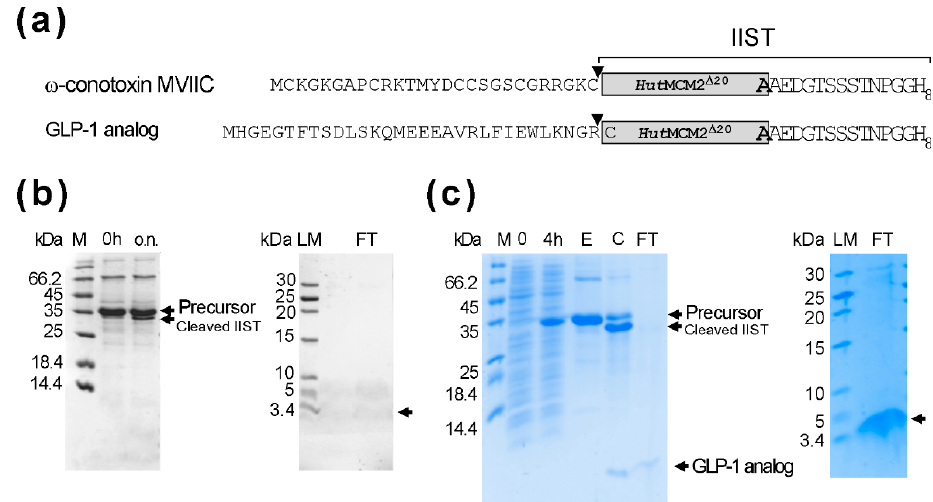
Figure 6. Expression and purification of a GLP-1 analog and ω -conotoxin MVIIC using the smaller IIST ( a ) A schematic drawing of the fusion constructs bearing a GLP-1 analog or ω -conotoxin MVIIC. Inverse triangles indicate the cleavage sites. ( b ) Salt-cleavage of ω -conotoxin MVIIC with the smaller IIST. 0 h and “o.n.” indicate the samples before the salt addition or after 15-h incubation in the salt solution (2 M NaCl, 50 mM DTT, 50 mM Tris-HCl, pH 7). LM and FT indicate low molecular weight markers and the flow-through fraction from the second IMAC, respectively. ( c ) Expression, purification, and cleavage of a GLP-1 analog with IIST. M stands for molecular weight markers. Lanes 0 h, 4 h, and E stand for samples at 0 h and 4 h after the protein expression and elution from the first IMAC, respectively. C and FT stand for the samples taken from the cleavage reaction and the flow-through fraction from the second IMAC, respectively. The samples were analyzed by 20% tricine-SDS-PAGE and stained with Coomassie brilliant blue. Tricine-SDS-PAGE analysis of the purified peptide from the second IMAC [30]. LM and FT indicate low molecular weight markers and the flow-through fraction from the second IMAC, respectively. Unlabeled arrows indicate the expected positions for the bands of the